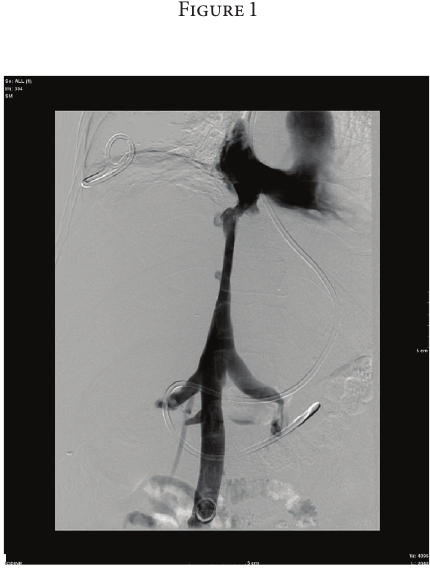
15 mm Hg. A 4010 Palmaz stent (Palmaz stent: Cordis